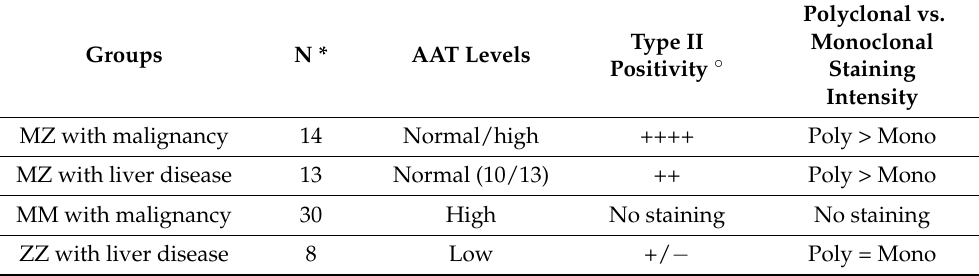
Table 1. AAT serum levels, Pi phenotypes and immunostaining pattern in liver specimen.